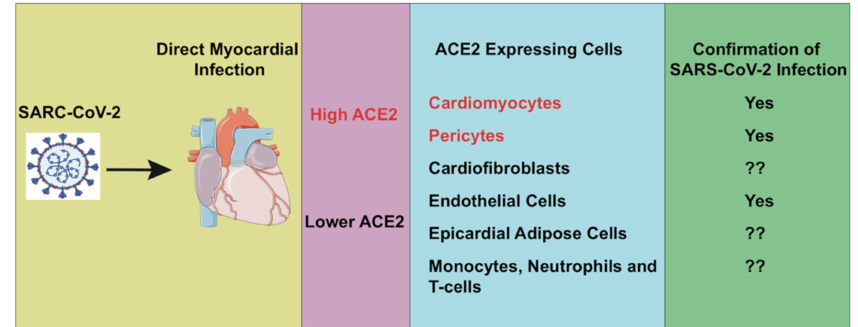
Figure 3. ACE2 expression and SARS-CoV-2 infection of heart cells. The potential SARS-CoV-2 direct infection in heart will be through ACE2-expressing cells, like cardiomyocytes and pericytes (high level expression of ACE2), while cardio-fibroblast, endothelial cells, epicardial adipose cells, and immune cells (low level expression of ACE2) may also be